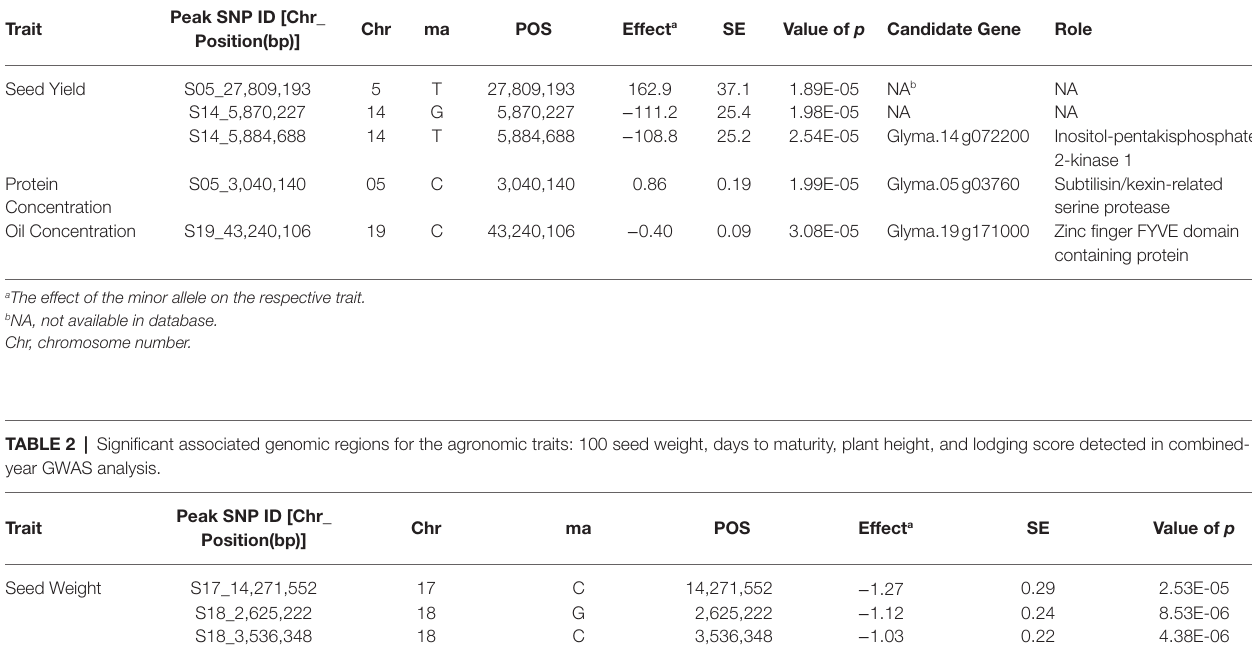
TABLE 1 | Significant associated genomic regions for soybean seed yield, seed protein, and seed oil concentrations detected in combined-year GWAS analysis. Trait